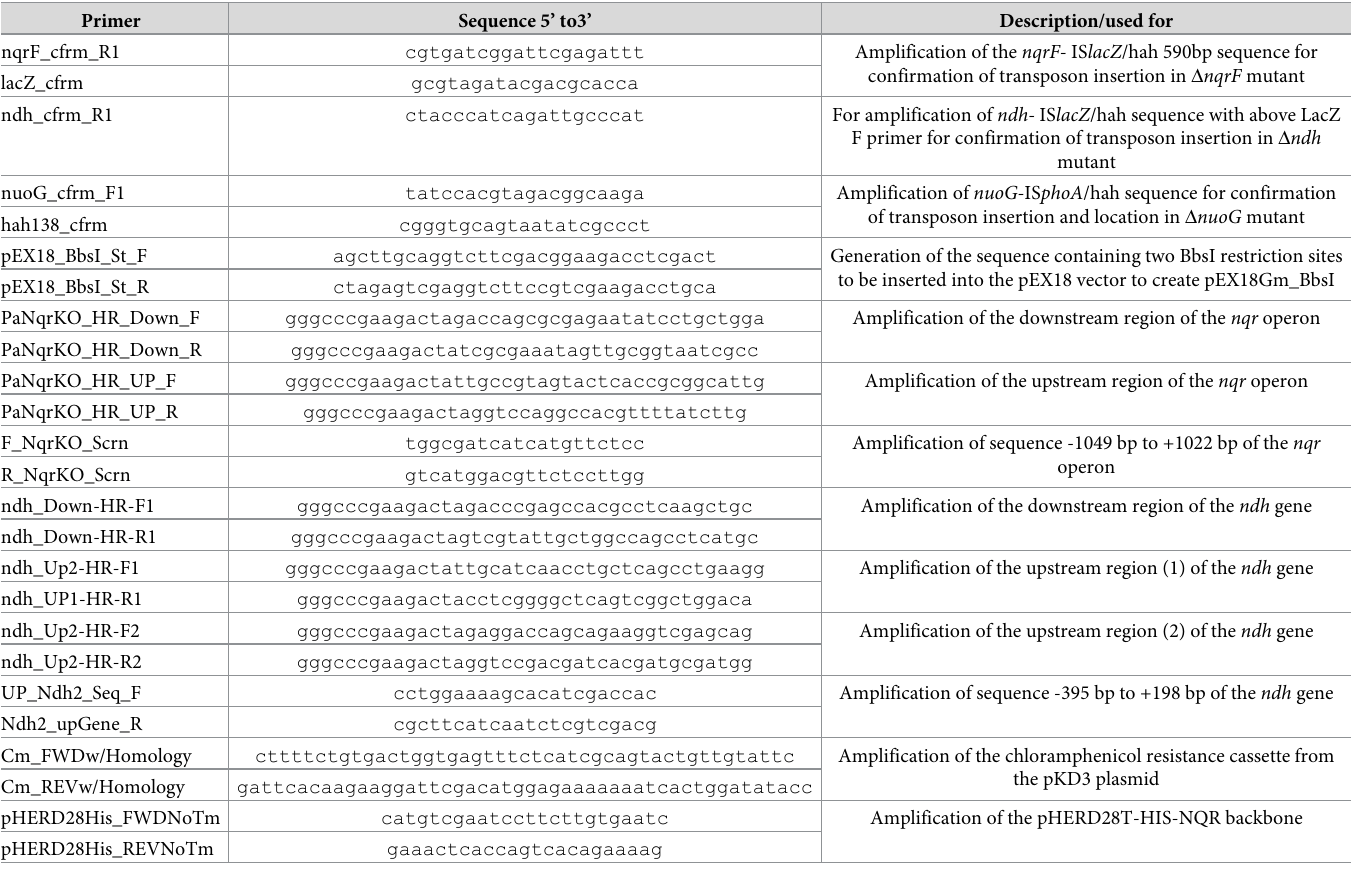
Table 2. Primers used in this study.